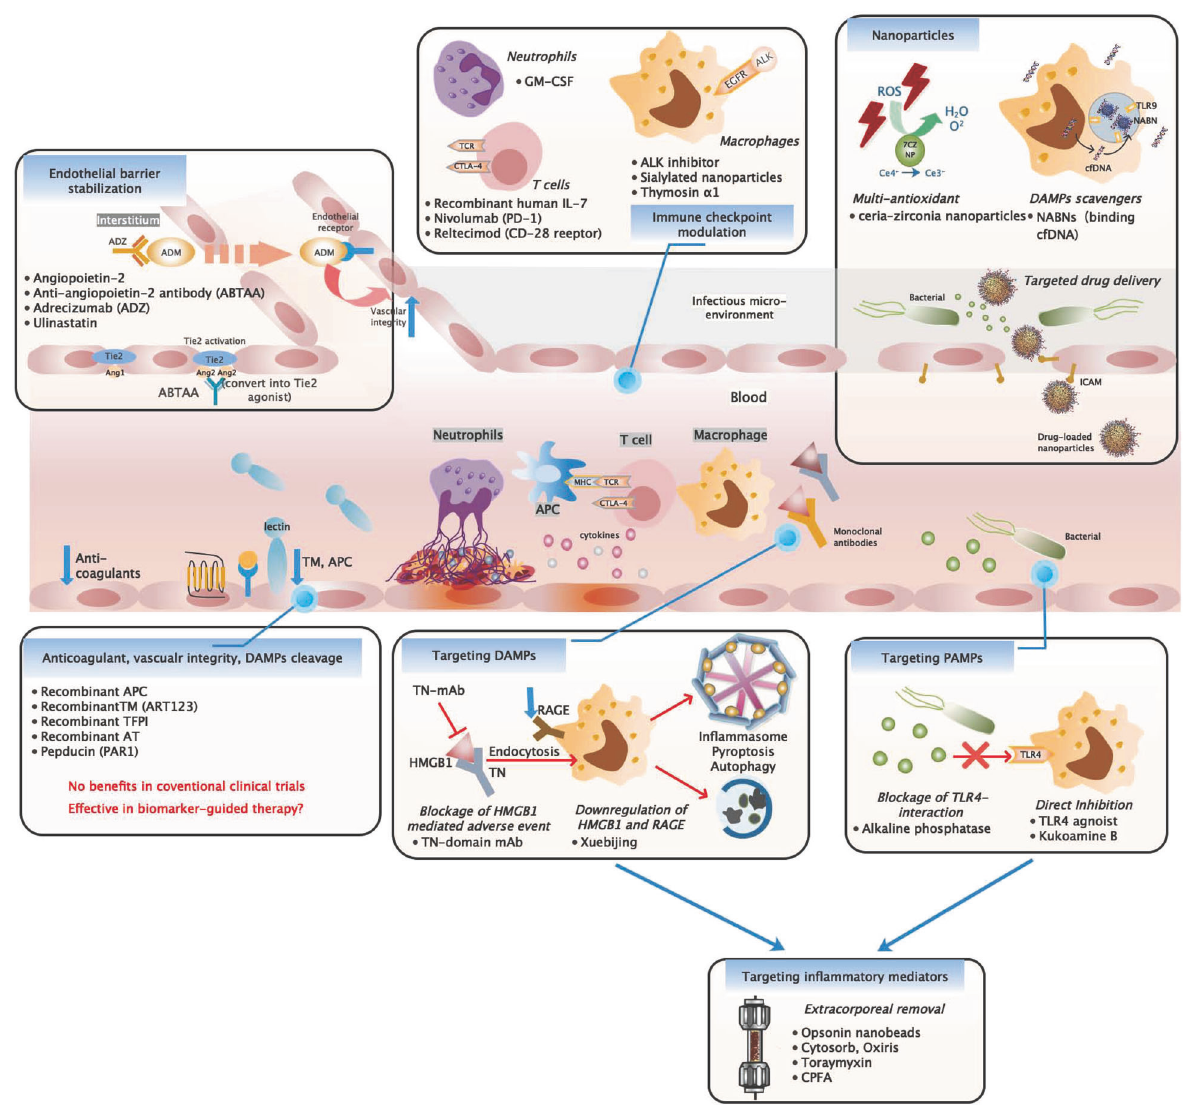
Fig. 5 Novel intervention therapeutic strategies in sepsis. In terms of the signaling pathways or molecules targeted, potential therapeutic strategies for sepsis that have been proposed so far could be classi fi ed into six categories: (1) targeting DAMPs (including host cell stress), (2) targeting PAMPs, (3) targeting in fl ammatory mediators (anti-in fl ammatory), (4) immune checkpoint modulation, (5) endothelial barrier stabilization, and (6) restoration of vascular anticoagulant properties. Nanoparticles therapy is a promising novel strategy that have broad therapeutic effects in sepsis experimental studies. Titles in italic refer to the speci fi c targeted mechanism (strategies). Dot-labeled subtitles refer to the speci fi c therapeutic techniques or bioactive molecules